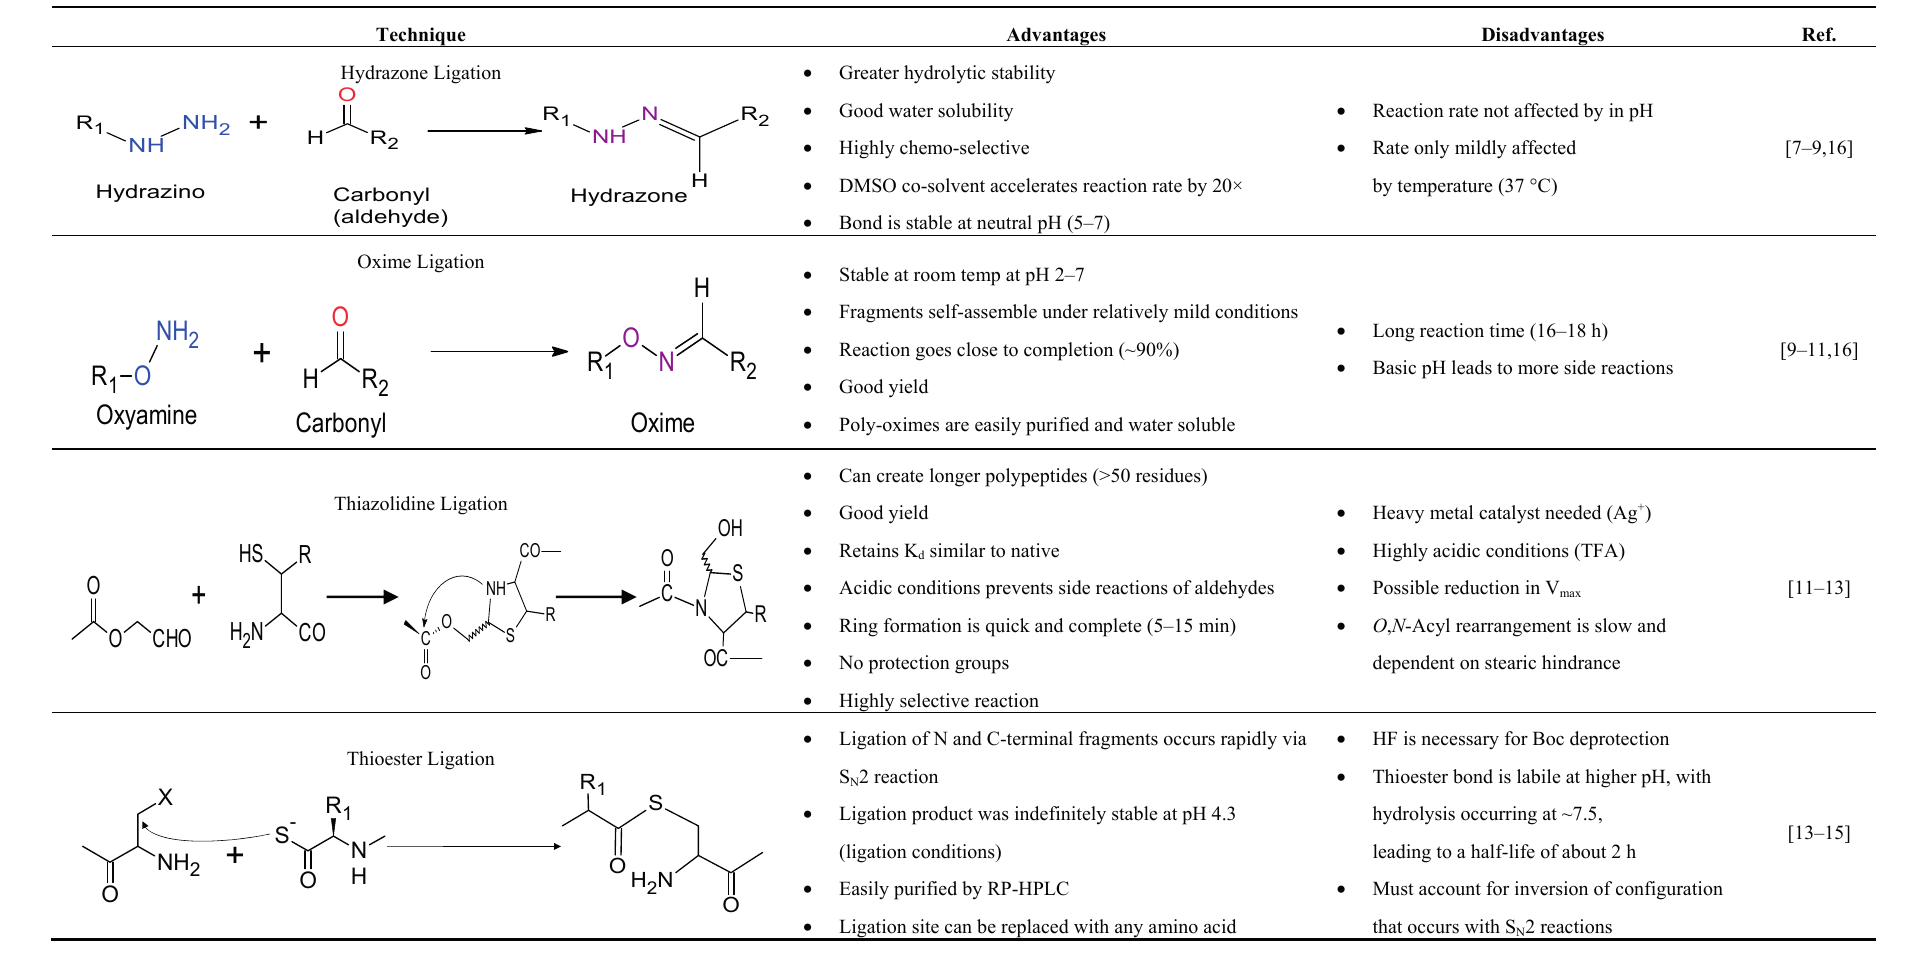
Table 1. Highlighting the advantages, disadvantages, and underlying mechanism of hydrazone, oxime, thiazolidine and thioester